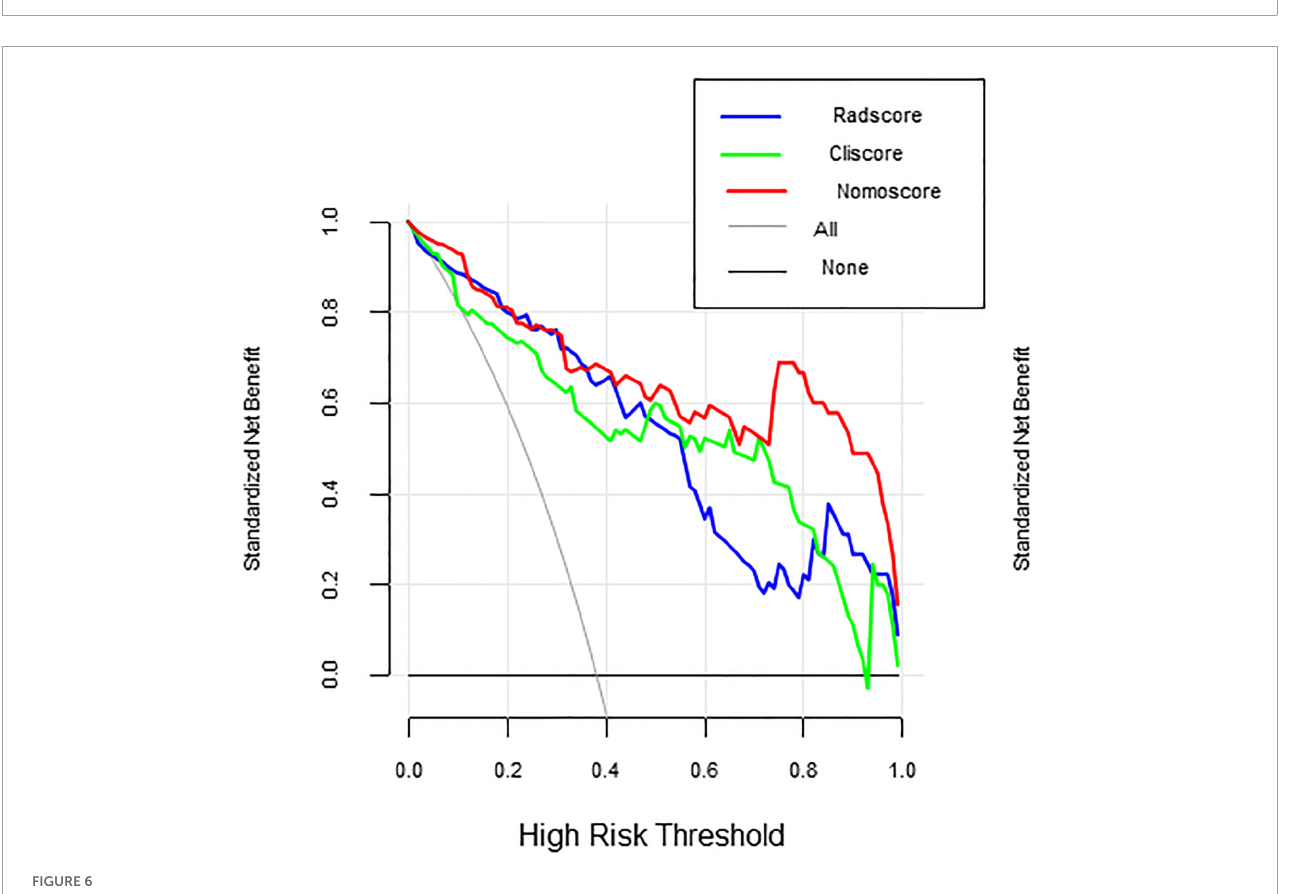
FIGURE6 Decision